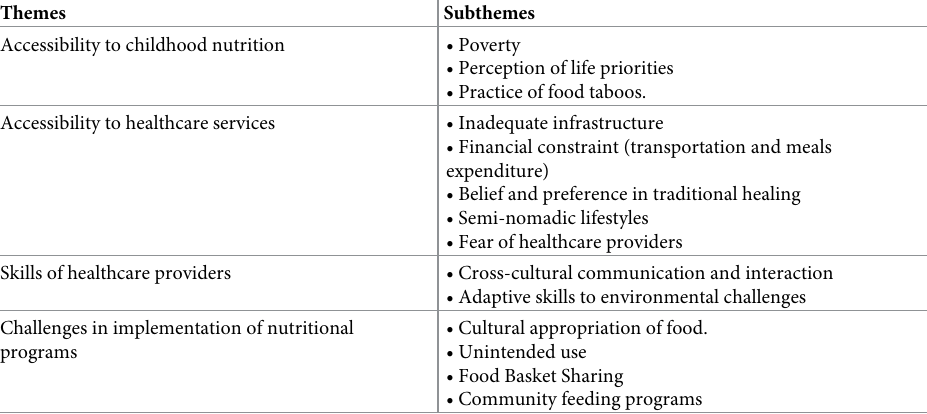
Table 2. Themes and subthemes